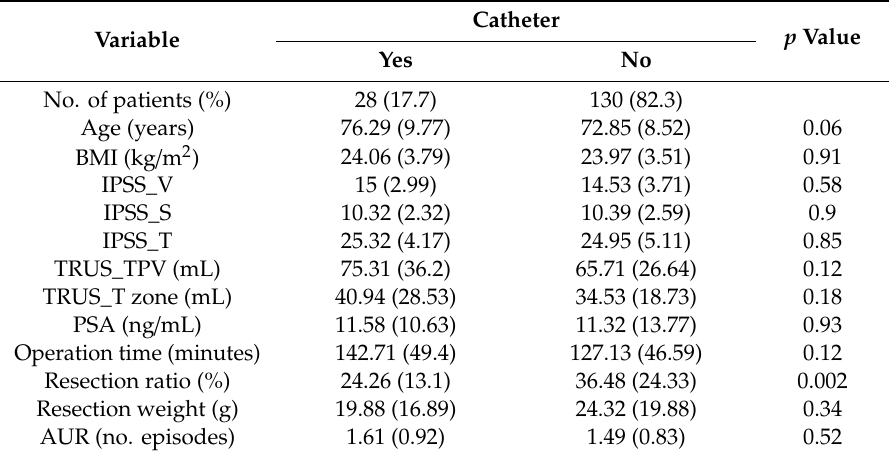
Table 3. Catheter usage on discharge.